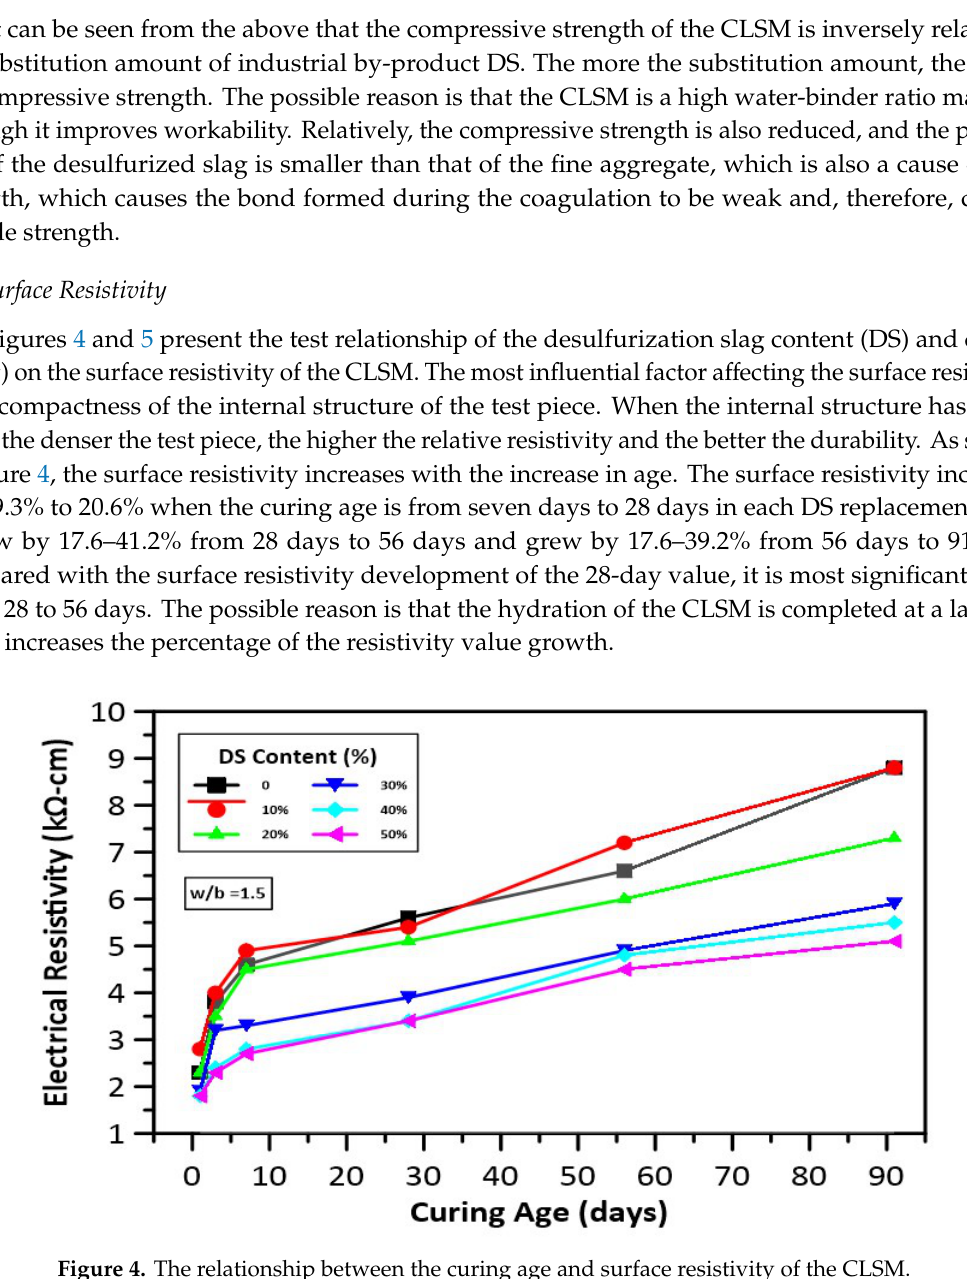
Figure 4. The relationship between the curing age and surface resistivity of the CLSM. Figure 5. The relationship between the DS content and surface resistivity of the CLSM.